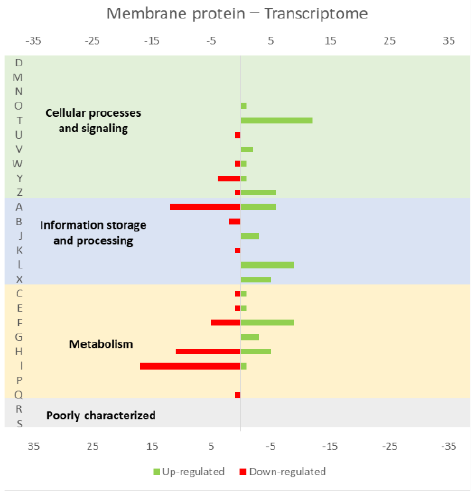
Figure 5. Effect of the membrane proteins overproduction in the L. lactis transcriptome. The graphs were constructed with compiled data from Pinto et al. [39] and represent the total number of tran- scripts up or down-regulated in each cellular process. The letters along the yy axis correspond to the following COG categories: A, RNA processing and modification (not used for prokaryotic COGs), B, chromatin structure and dynamics, C, energy production and conversion, D, cell cycle control and mitosis, E, amino acid metabolism and transport, F, nucleotide metabolism and transport, G, carbohydrate metabolism and transport, H, coenzyme metabolism, I, lipid metabolism, J, transla- tion, K, transcription, L, replication and repair, M, cell wall/membrane/envelope biogenesis, N, Cell motility, O, post-translational modification, protein turnover, chaperone functions, P, Inorganic ion transport and metabolism, Q, secondary metabolites biosynthesis, transport and catabolism, T, signal transduction, U, intracellular trafficking and secretion, Y, nuclear structure (not applicable to prokaryotic COGs), Z, cytoskeleton (not applicable to prokaryotic COGs); R, general functional prediction only (typically, prediction of biochemical activity), S, function unknown